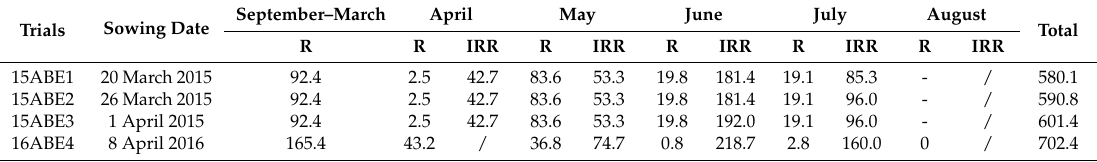
Table 1. Rainfall and irrigation (mm) during the two wheat-growing seasons for the 4